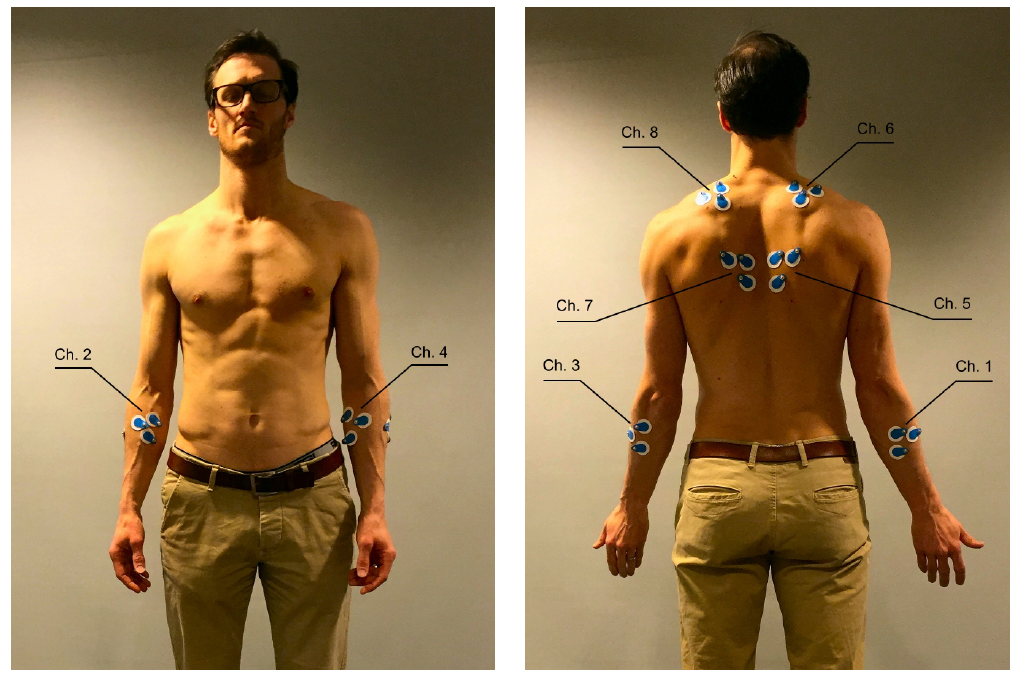
Figure 1. Participant body with eight-channel EMG recorder electrodes attached. Electrodes on extensor digitorum communis (EDC) arm muscles can be seen in the front side view ( Left ); electrodes on flexor carpi radialis (FCR) arm muscles, as well as electrodes on rhomboideus and trapezius muscles can be seen in the back side view ( Right ). Mapping between a channel number and a muscle: (1) right FCR ; (2) right EDC ; (3) left FCR ; (4) left EDC ; (5) right rhomboideus ; (6) right trapezius ; (7) left rhomboideus ; and (8) left trapezius